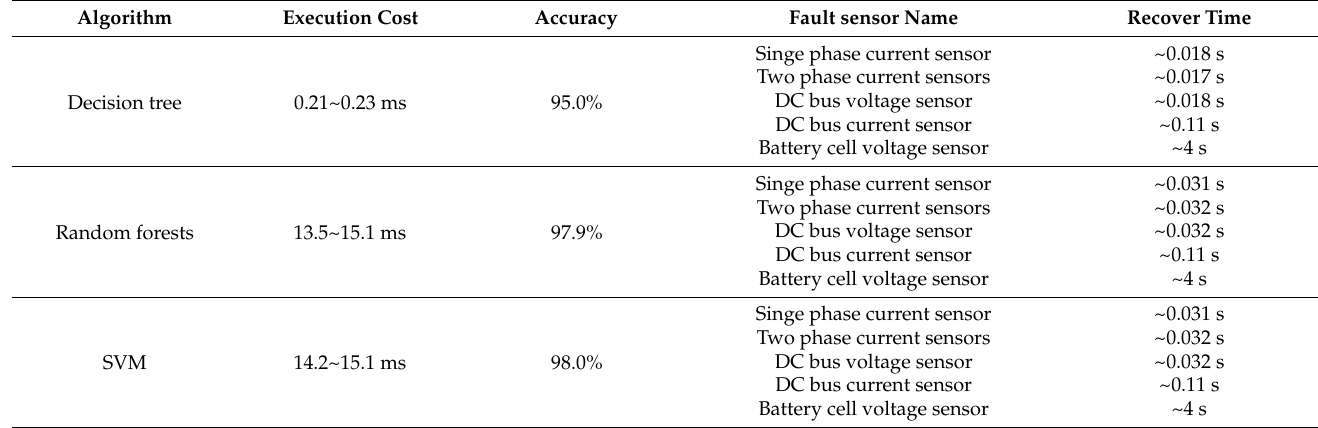
Table 5. Evaluation result